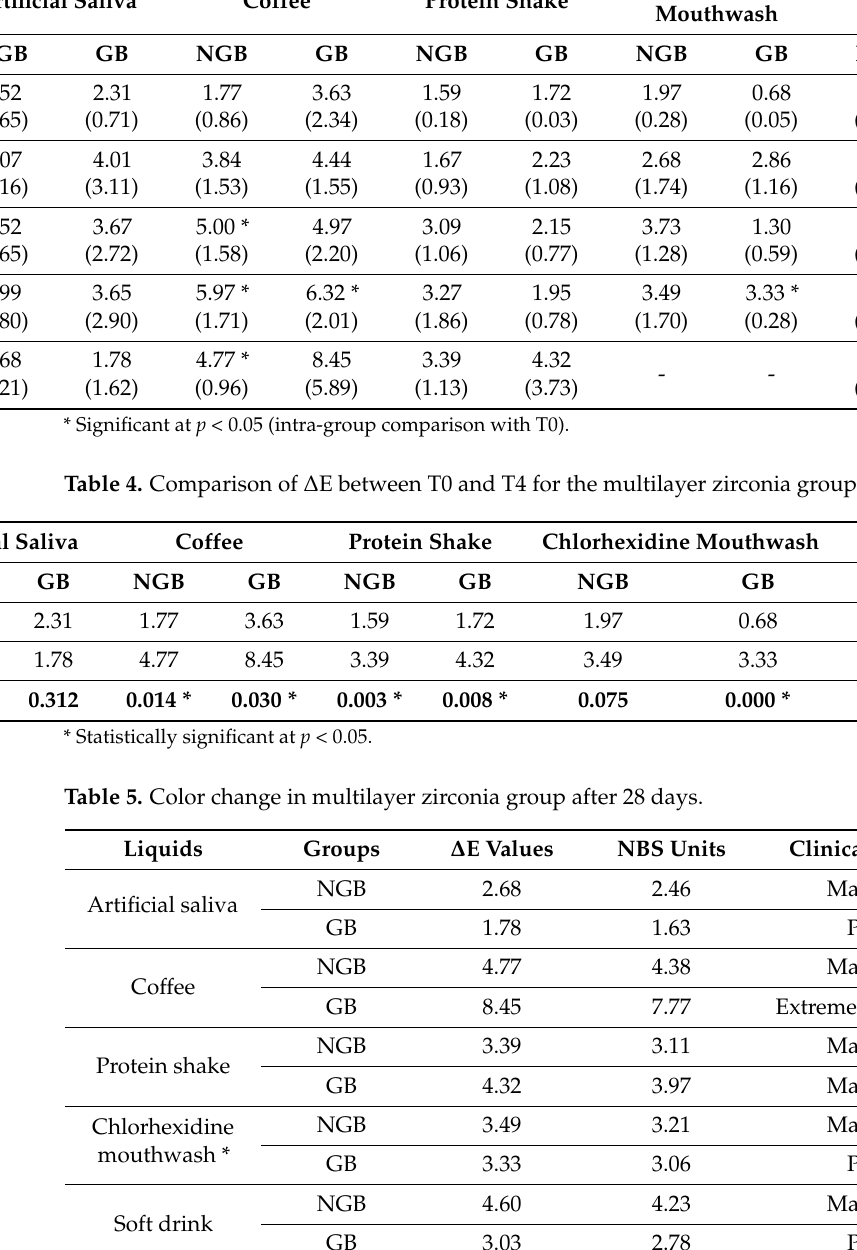
Table 6. The greatest ∆ E was observed for GB zirconia samples (9.10) at T4 after immersion into the coffee, while the greatest ∆ E for NGB zirconia samples (6.81) was also seen after they were immersed in coffee at T4 (Table